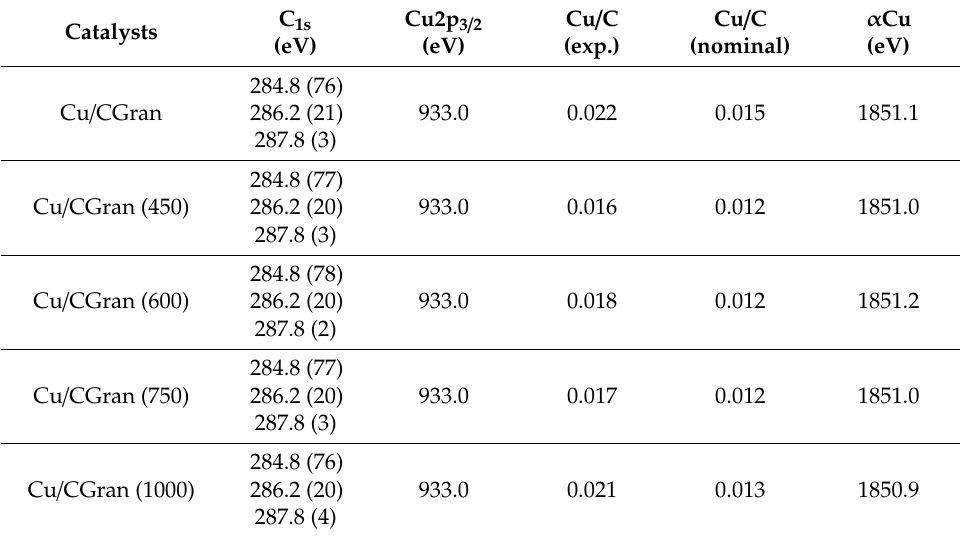
Figure 5. XP spectra of Cu 2p in reduced catalysts ( a ) Cu / CGran, ( b ) Cu / CGran(750), and C1s XP spectra for ( c ) Cu / CGran catalysts. Bond energies (eV) and surface atomic ratios of copper carbon species (Cu / C) of Cu / CGran(x)